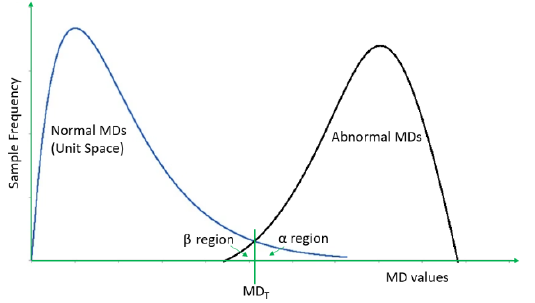
Figure 4. Thresholding (MD T ) point using Type-I and Type-II errors.